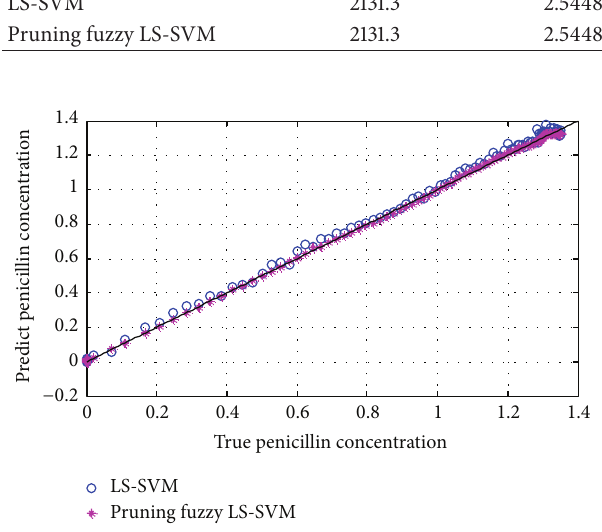
Figure 8: 45-degree comparison of the two soft